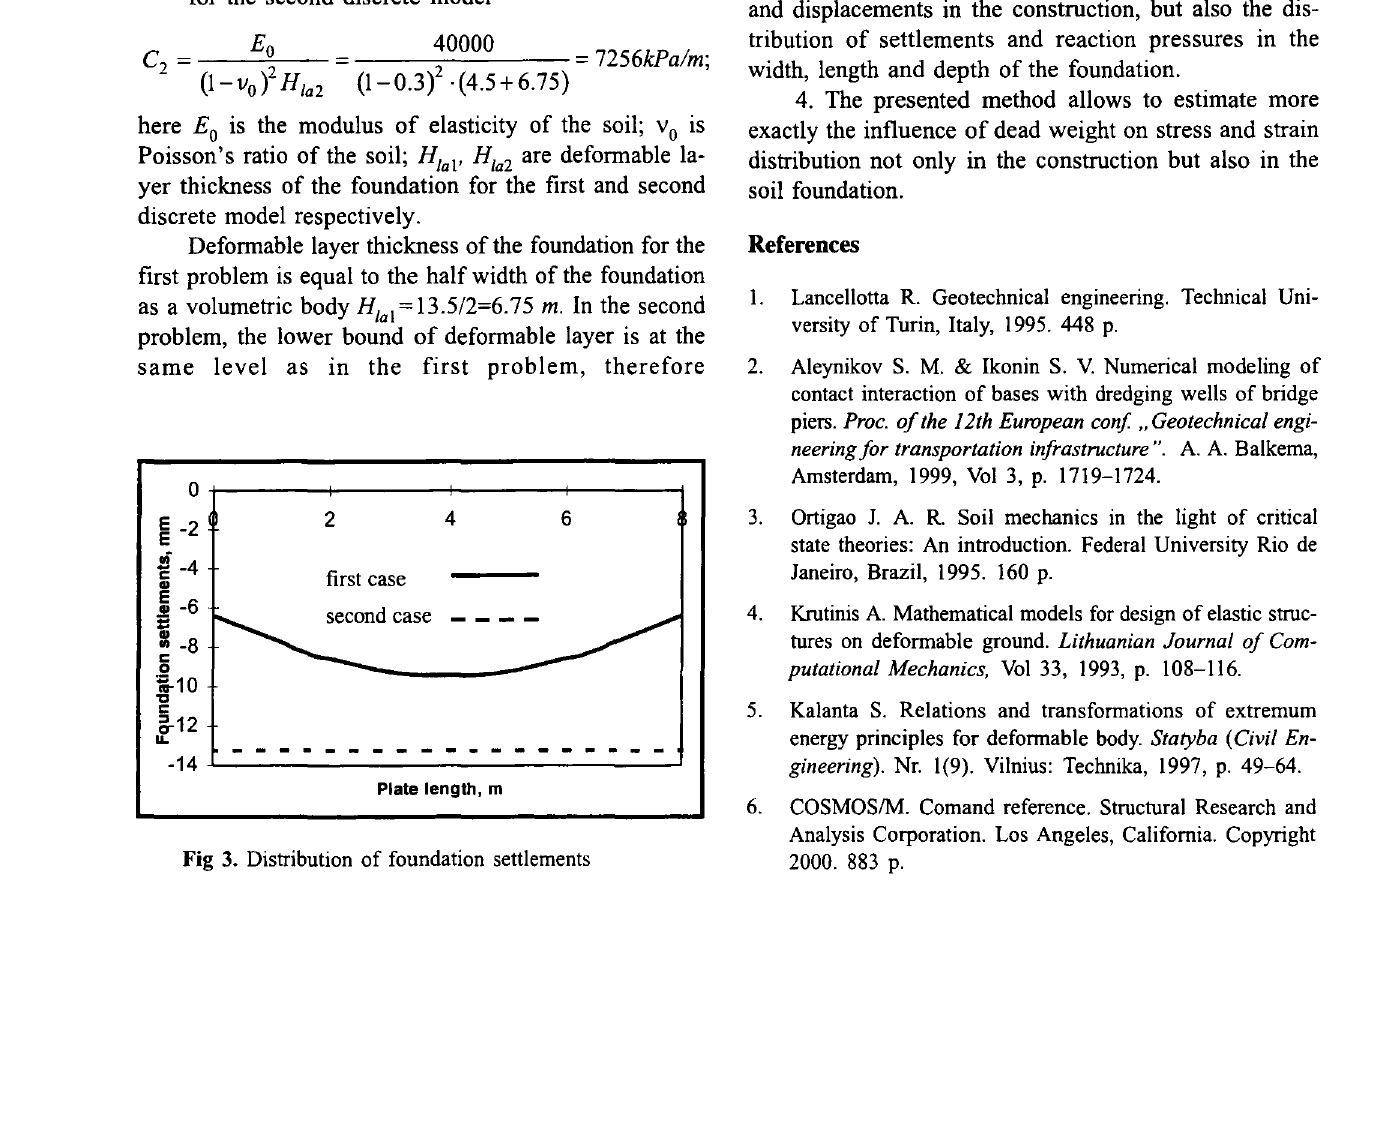
Fig 3. Distribution of foundation